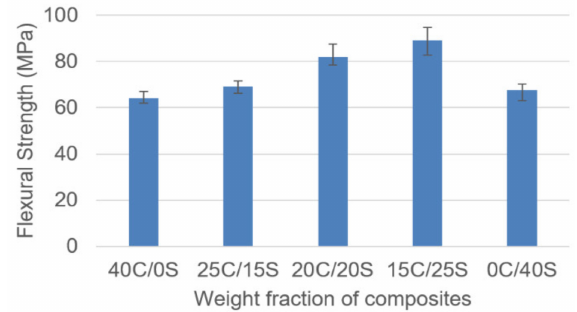
Figure 7. Flexural strength vs. weight fraction of C/S composites.